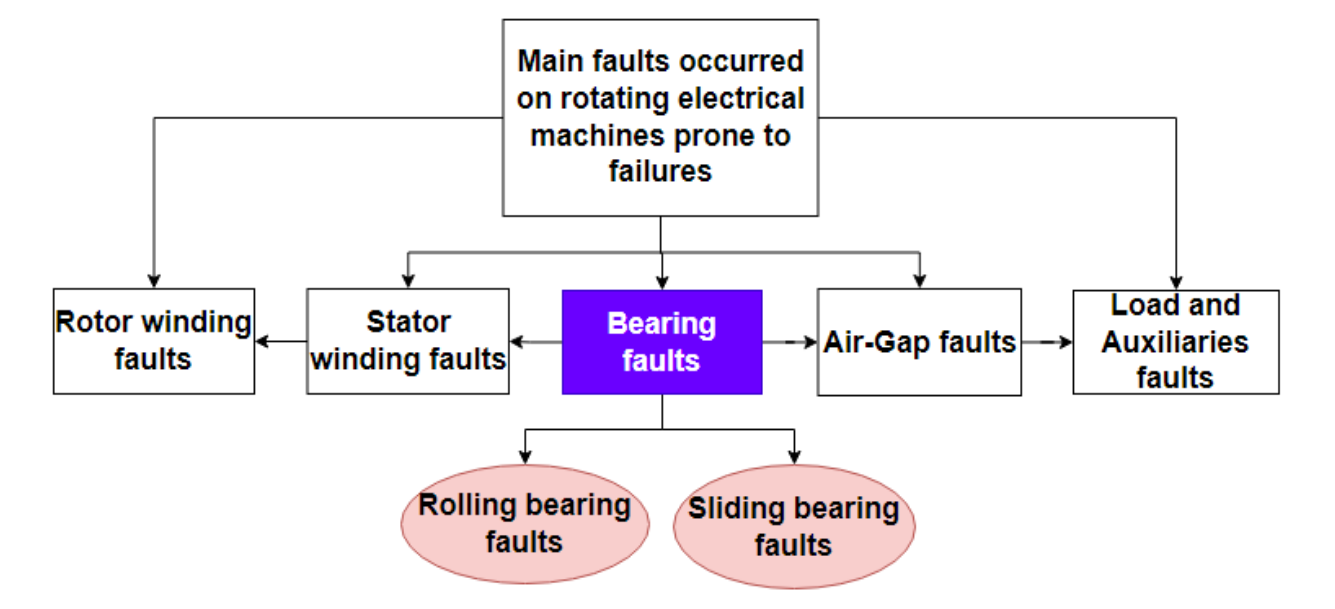
Figure 4. A variety of different faults occurring in rotating electrical machines. There are three targets of failure analysis: detection, isolation, and identification.